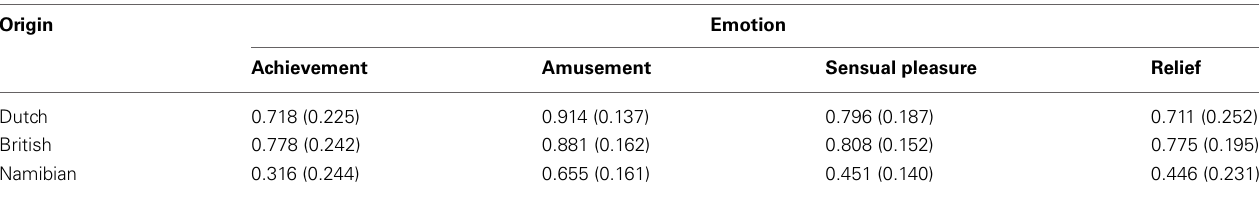
Table A1 | Performance on the emotion recognition task in Experiment 1, with accuracy for Dutch, British, and Namibian stimuli shown for each emotion separately.